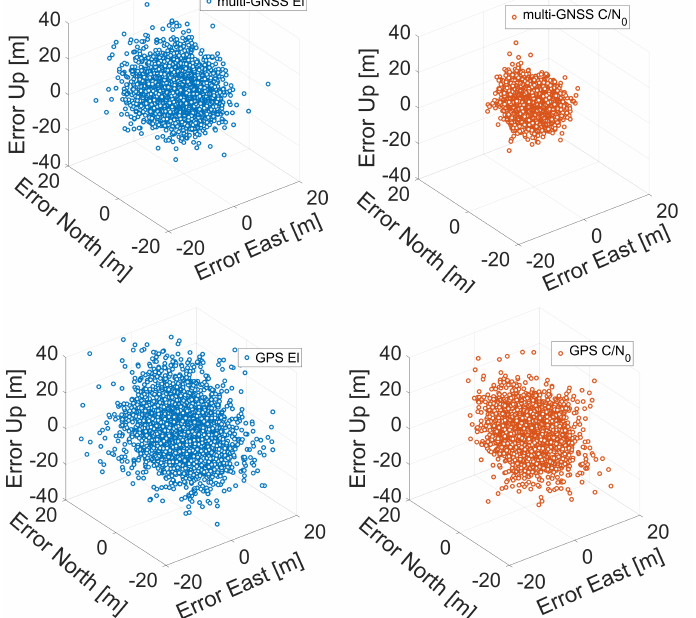
Figure 8. Three-dimensional coordinate error scatter plots for single point positioning of Xiaomi Mi 9. The first row corresponds to multi-GNSS solution while the second row to the GPS one. Blue markers represent errors when the solution was obtained using elevation-dependent weights; red circles represent errors obtained using C / N 0 weights.